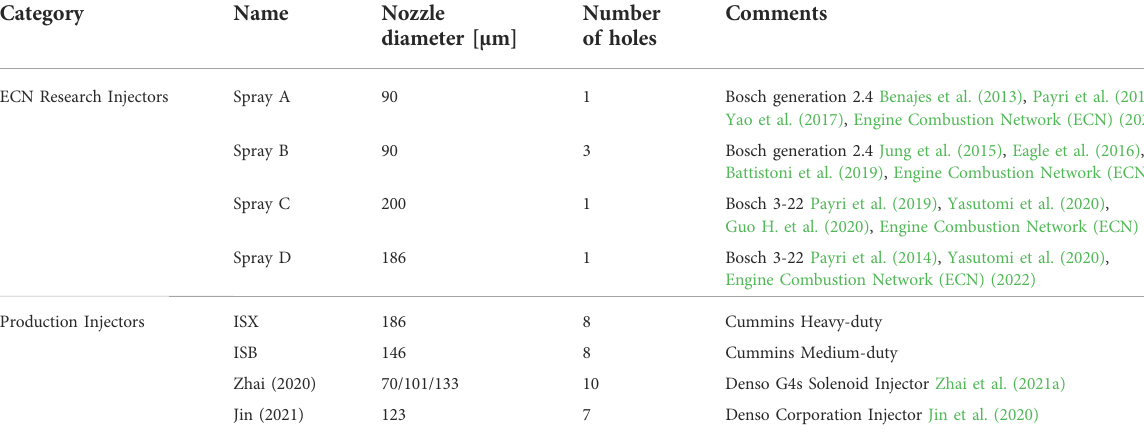
TABLE 1 Speci fi cation of diesel injectors used by the ECN, in the literature and this study. Category